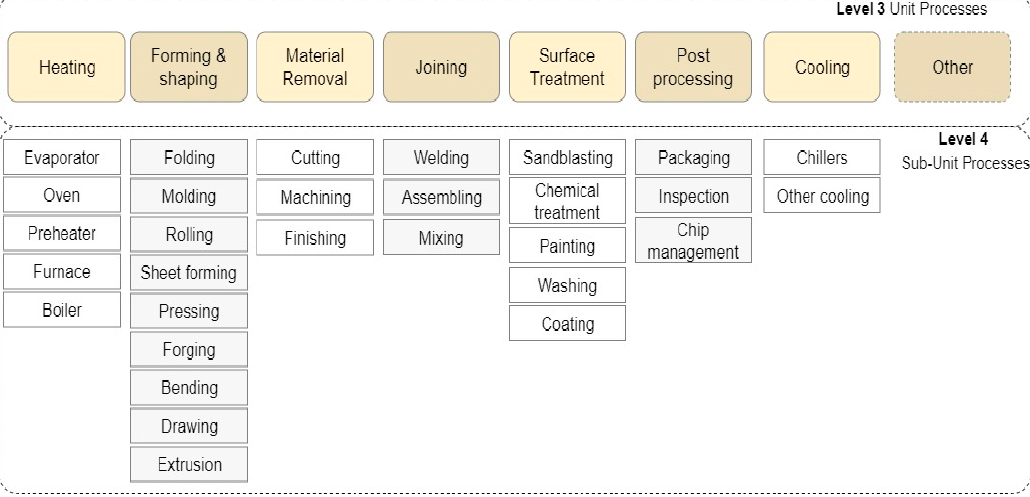
Figure 6. Process tree showing Level 4 production categories of energy use taxonomy in the engineering industry.